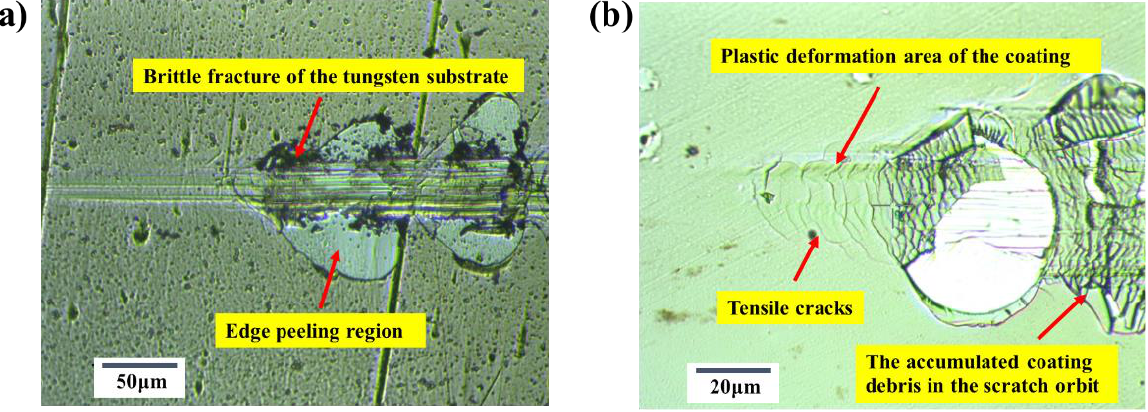
Figure 13. The scratched critical failure zone of Ta-Hf-C coating ( a ) on tungsten substrate ( b ) and the stainless steel substrate.